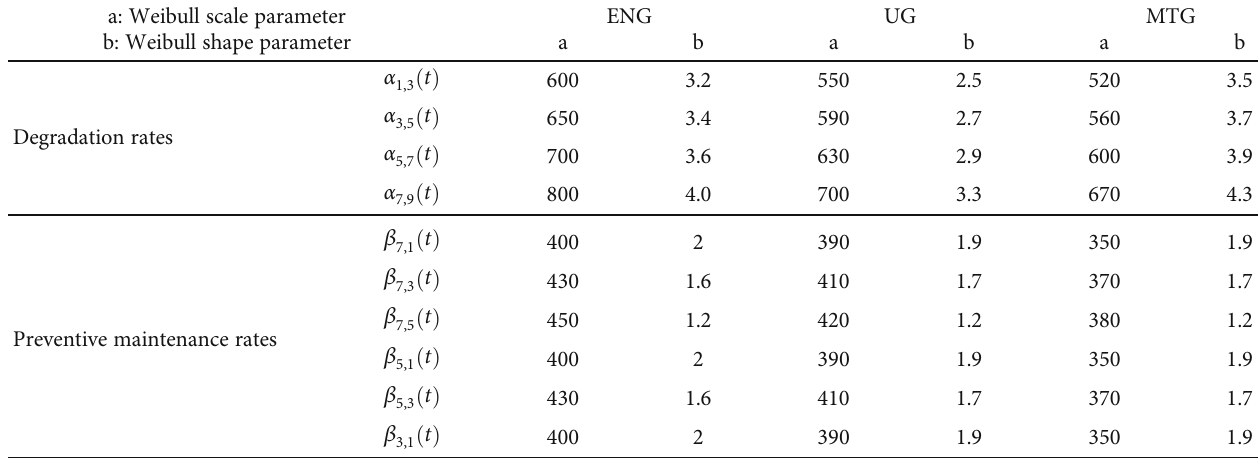
Table 3: Transition rates of assemblies with Weibull distribution.